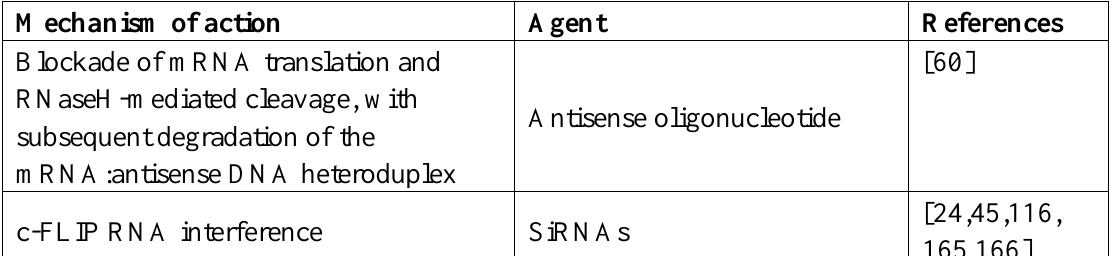
Table 2. Agents known to inhibit c-FLIP expression by post-transcriptional mechanisms. Mechanism of